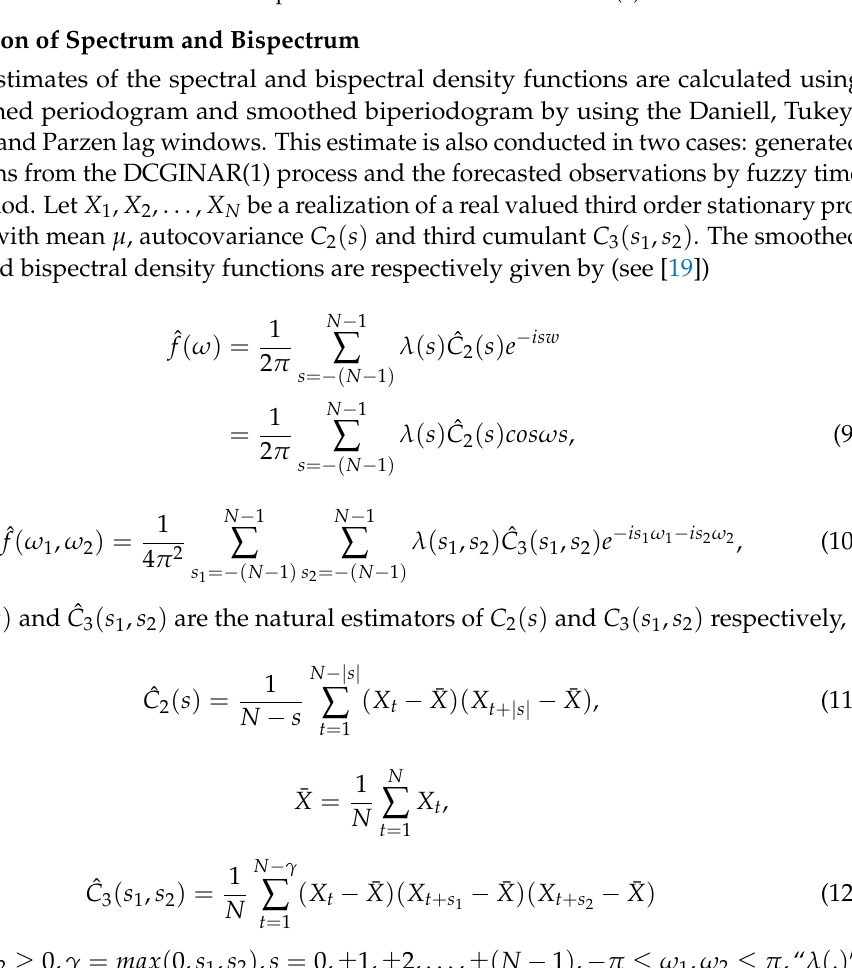
Figure 5. The theoretical normalized bispectral modulus of the